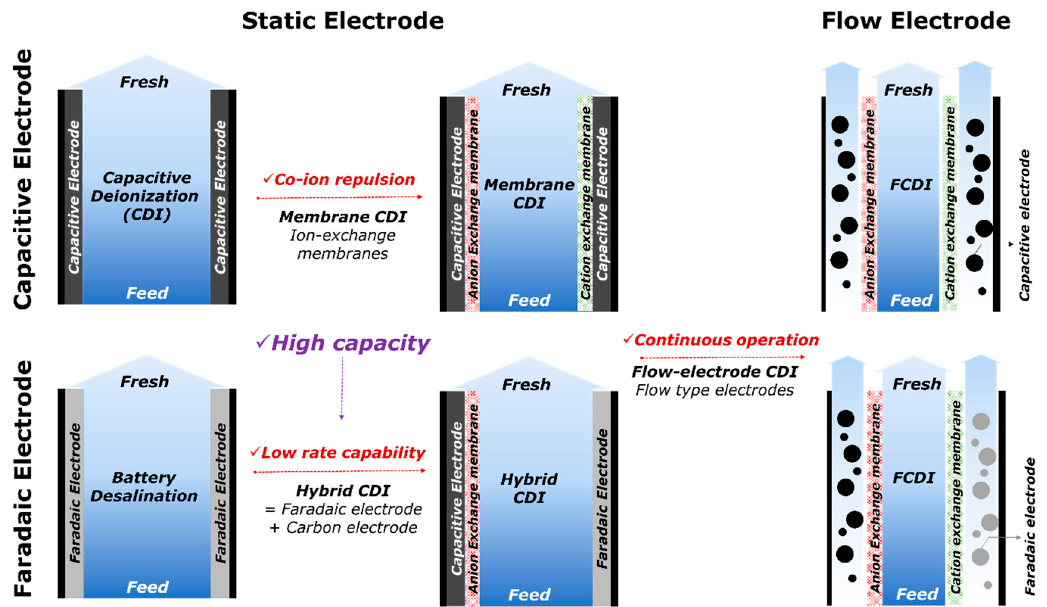
Figure 3. Fundamental development of the cell architectures in CDI using the static and flow electrodes.